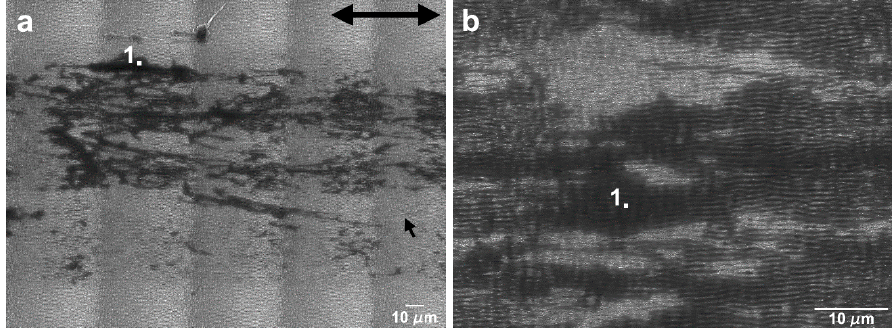
Figure 12. Energy-dispersive X-ray spectrometry (EDS) point analysis on the wear tracks produced with 25 mN load and ( a ) 50 cycles and ( b ) 1000 cycles. The double arrow indicates the sliding direction.